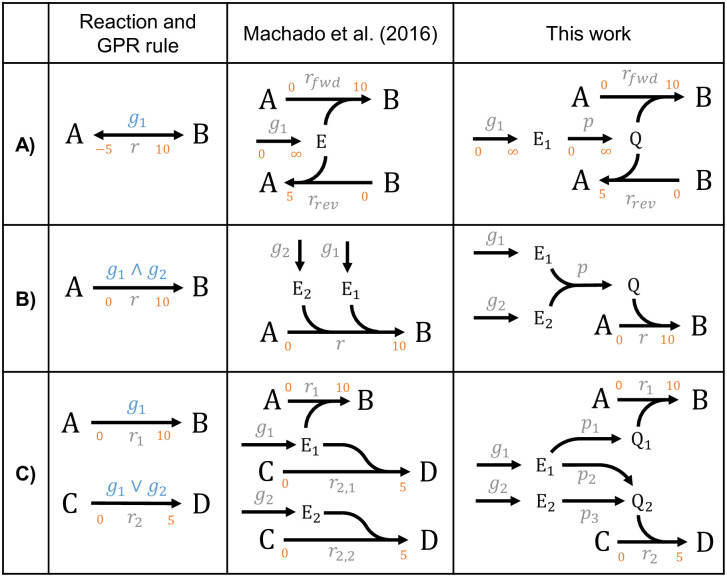
Integration of GPR rules into the metabolic network structure.In contrast to the approach of Machado et al. [25], in the variant introduced herein, every reaction with a GPR rule consumes a pseudo-metabolite Q that represents a pool of enzymes catalyzing this reaction. Example cases: A) reversible reactions; B) enzymes with subunits; C) promiscuous enzymes (g1) and isoenzymes (g1, g2).